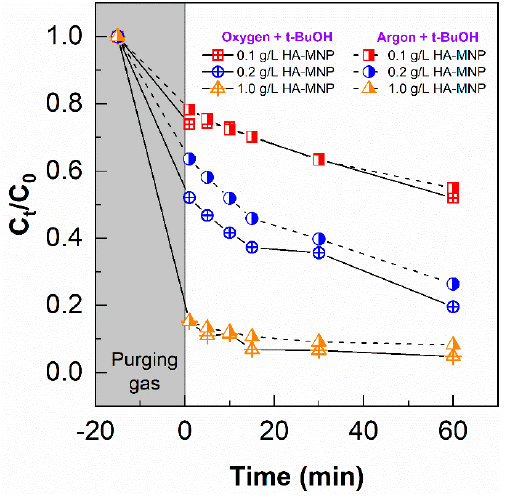
Figure 8. The removal of As(III) in the presence of an • OH quencher and in the presence and absence of molecular oxygen during photo-irradiation with UVA for 60 min. [HA-MNP] = 0.1, 0.2, and 1.0 g L − 1 ; [As(III)] 0 = 200 µ g L − 1 and [ t -BuOH] = 10 mM.